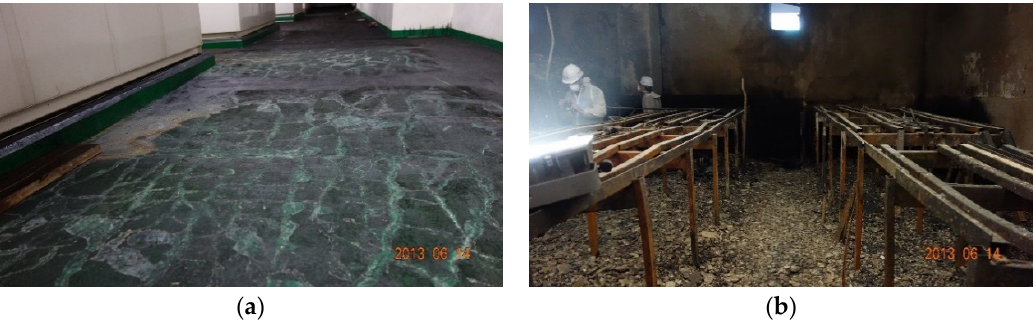
Figure 4. ( a ) Damage to top surface of Slab #3 and ( b ) pileup of debris under Slab #3 and #4.